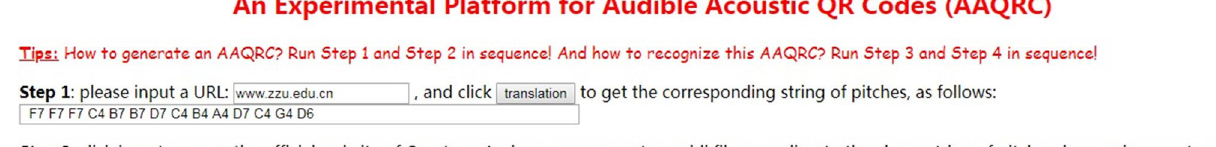
Figure 2. An example on AAQRC generation: step 1.